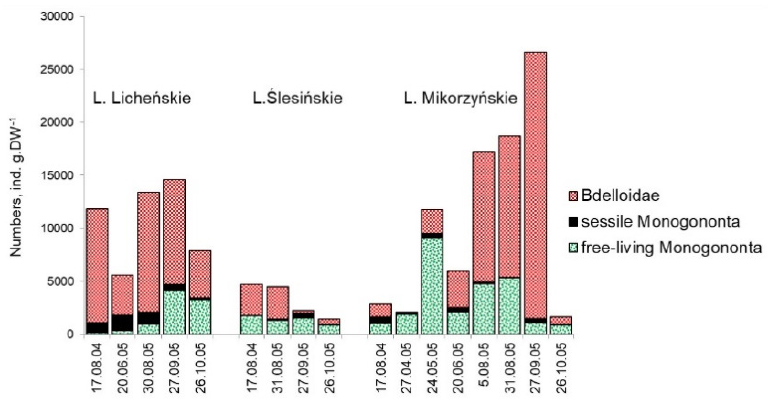
Figure 6. Density of three taxonomic and functional groups of Rotifera epiphytic on Vallisneria in the three Konin lakes in the years 2004 and 2005.